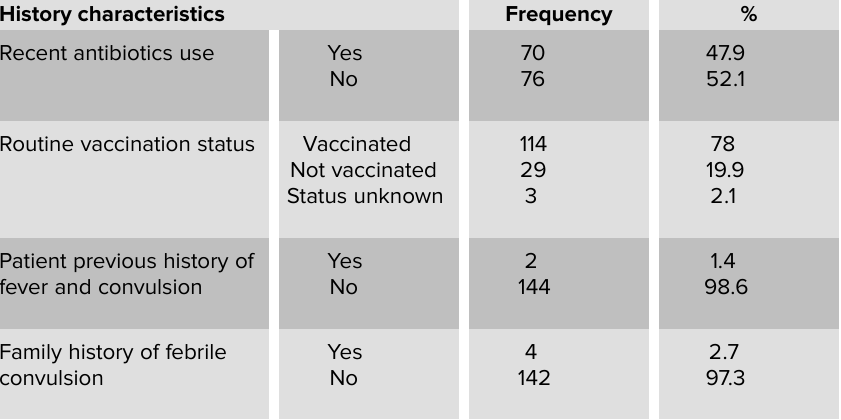
Table 2: Distribution of the study population according to history characteristics (n =